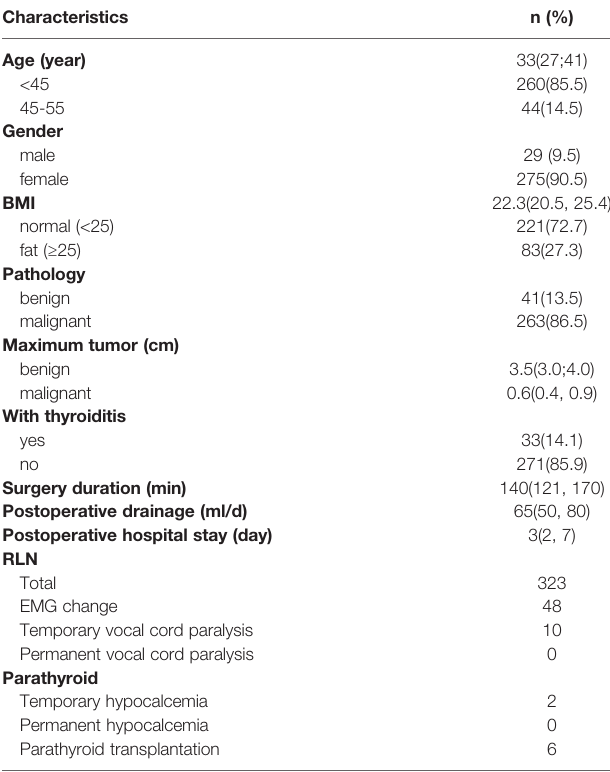
TABLE 4 | Clinicopathological data of 304 patients with thyroid surgery. Characteristics